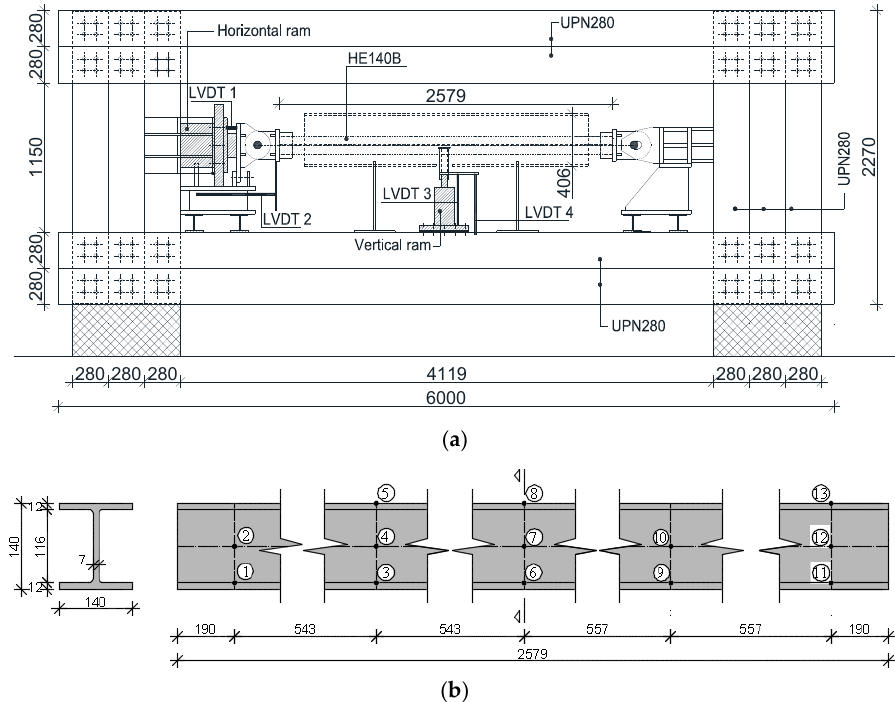
Figure 2. ( a ) Test frame schematics (units in mm); ( b ) measuring point for temperature (units in mm).